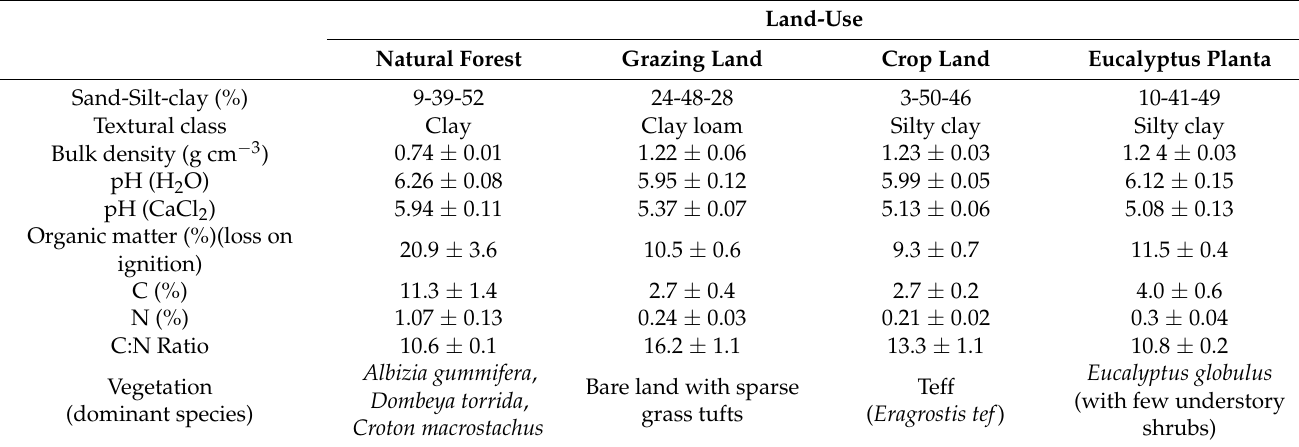
Table 1. General characteristics of soils (0–10 cm) in different land-use types under